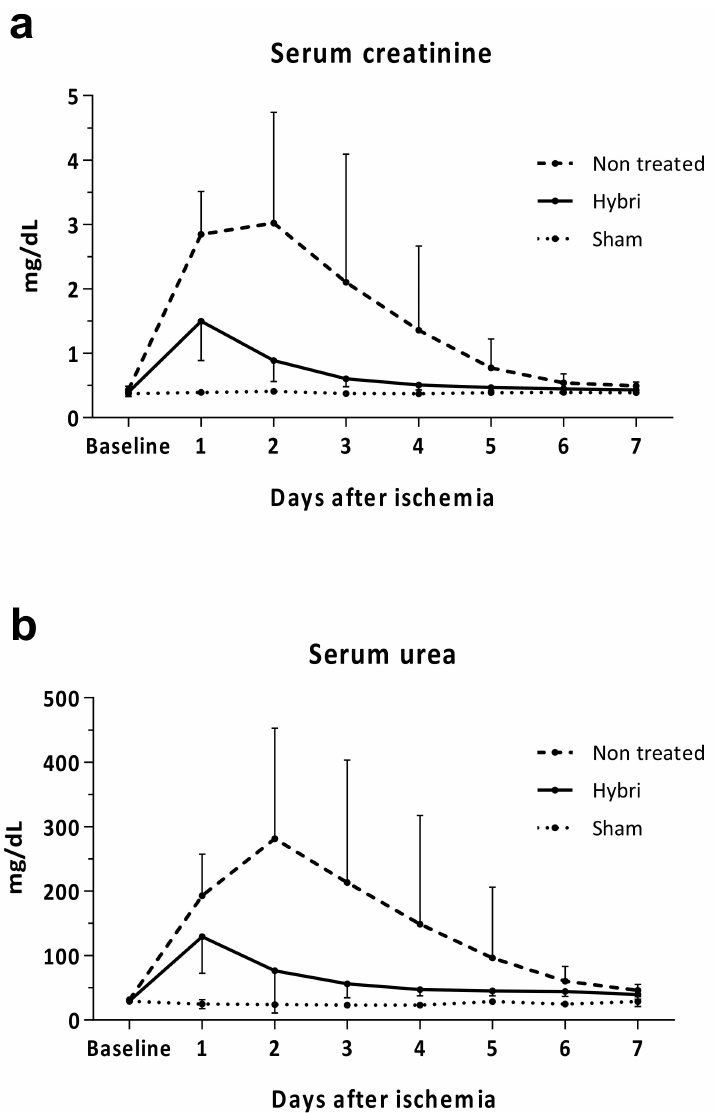
Figure 3. Functional renal parameters throughout the ischemia-reperfusion model for all treatments, including serum creatinine ( a ) and serum urea ( b ). Values are expressed in mg/dL. Data are expressed as